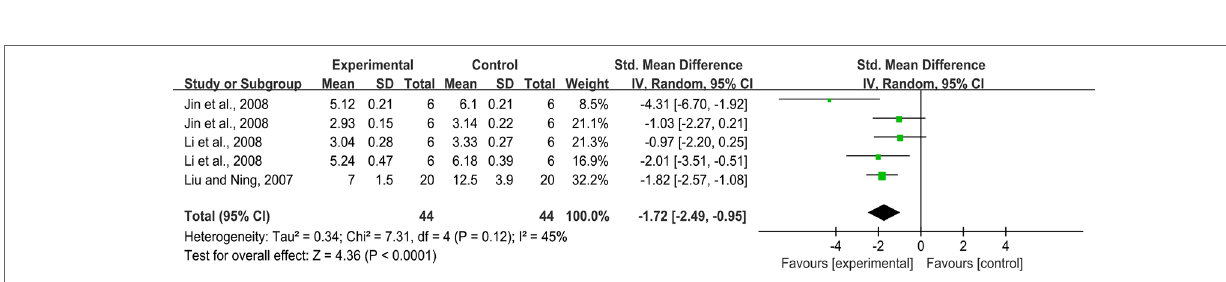
FiGURe 6 | Pooled estimate of relative area of kidney collagen fiber with rhein.